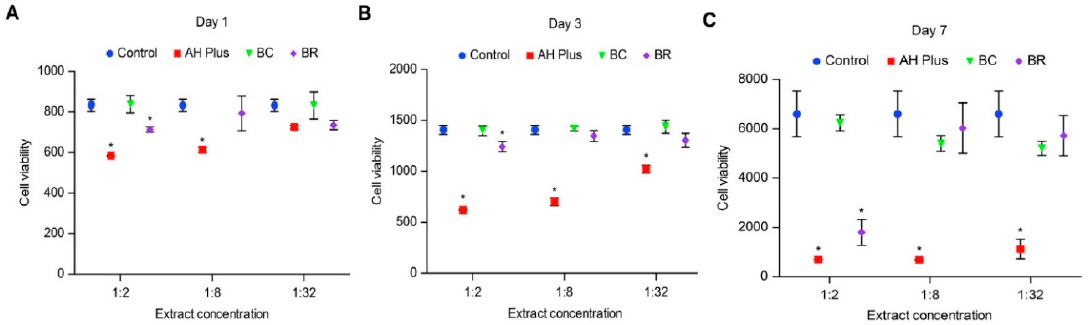
Figure 1. Cell viability of human bone marrow mesenchymal stem cells (hMSCs) cultures exposed to